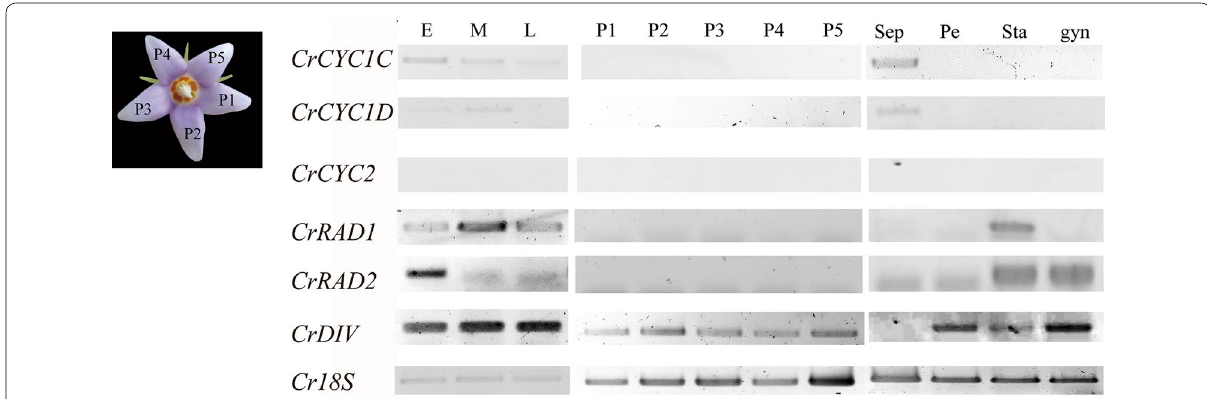
Fig. 5 Gene‑specific reverse transcriptase polymerase chain reaction (RT‑PCR) analysis of CrCYC , CrRAD and CrDIV genes from C. ramondioides buds and dissected flower tissues. E, M, L represent three flower development stage defined in this study. E stands for early flower development stage; M stands for middle flower development stage; L stands for anthesis stage. P1 to P5 represent dissected petal from flower bud at early (E) flower developmental stage. Sep, Pe, Sta and gyn denote pooled sepals, pooled petals, pooled stamens and gynoecium dissected from early flower developmental stage. CrCYC1C , CrCYC1D and CrCYC2 indicate expression of CrCYC1C , CrCYC1D and CrCYC2 . CrRAD1 and CrRAD2 indicate expression of CrRAD1 and CrRAD2 . CrDIV indicates expression of CrDIV . 18S is included as a positive control. CrCYC1C , CrCYC1D , CrRAD1 , CrRAD2 and CrDIV are detected through flower development stages, only CrCYC2 is restricted through flower development stages. CrDIV is detected in all petals, whereas CrCYC1C , CrCYC1D , CrCYC2 , CrRAD1 and CrRAD2 are restricted in petals. CrCYC1C and CrCYC2 were detected in pooled sepal